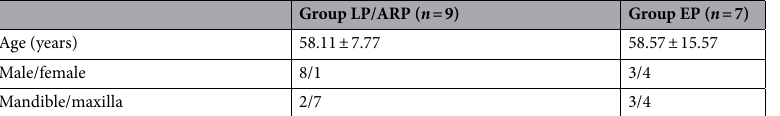
Table 1. Demographic information. Group LP/ARP: late implant placement following 4 months of alveolar ridge preservation, Group EP: early implant placement.